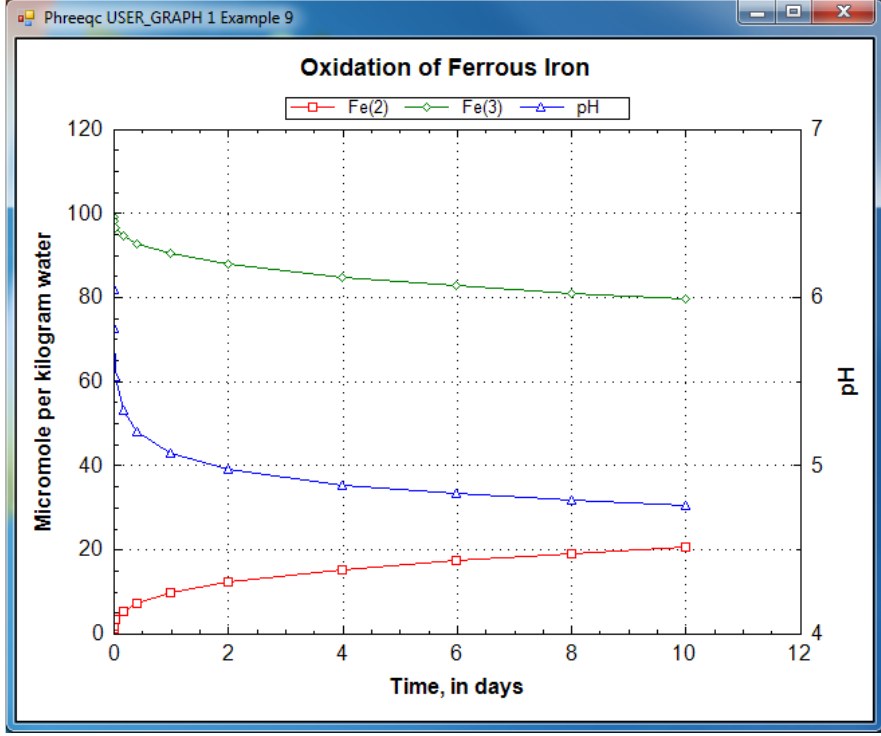
Figure 10. Concentration of total Fe(2), total Fe(3), and pH as dissolved